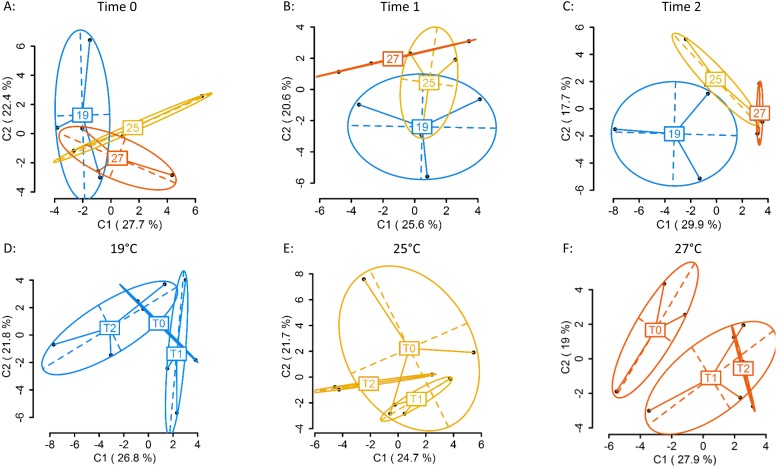
 Principal Coordinate Analysis (PCoA) of methylation (MSL) differences between colonies exposed 19, 25 and 27 °C.(A) between colonies at Time 0 (T0), prior to elevated temperature exposure (baseline methylation); (B) between colonies at Time 1 (T1) following a gradual temperature increase of 1 °C per day until all treatment temperatures were reached: 19 °C (control) (n = 3), 25 °C (n = 3) and 27 °C (n = 3); (C) at Time 2 (T2)* after three days of elevated temperature exposure; (D) between sampling time points (T0, T1, T2) in colonies held at 19 °C; (E) 25 °C; (F) 27 °C*. The first two coordinates (C1 and C2) are shown with the percentage of variance explained by them. Points in each group cloud represent individuals from different groups. Temperature labels show the centroid for the points cloud in each group. Ellipses represent average dispersion of those points around their centre (Pérez-Figueroa, 2013). AMOVA tests for significant differences in methylation (MSL) are shown in Tables S3 and S4. * represents significant difference (p < 0.05).